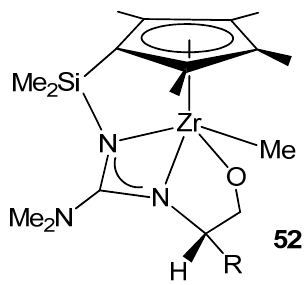
Figure 30. Chiral half-sandwich complexes with an oxazolinato group.